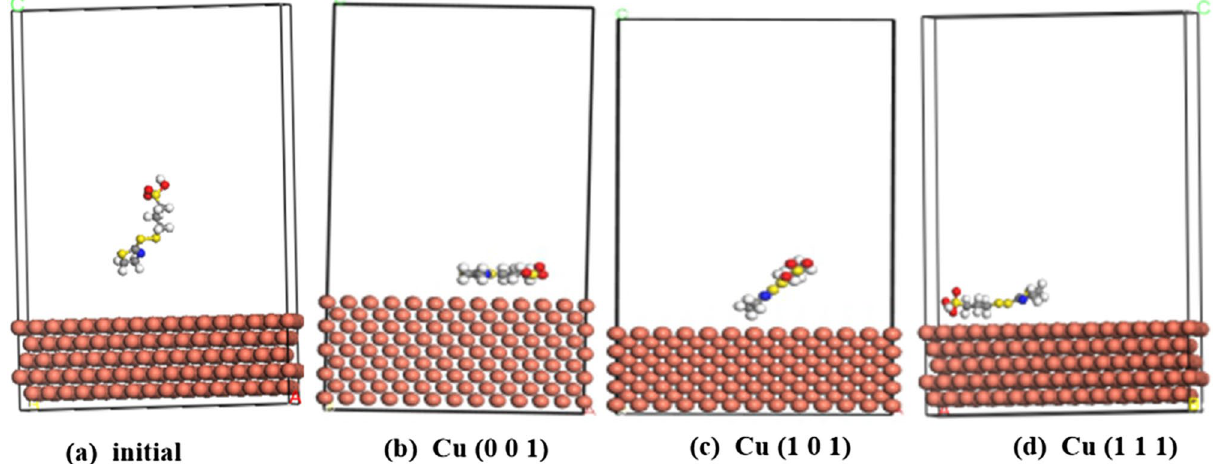
Figure 5. Configuration of SH110 adsorbed on Cu (001), Cu (101) and Cu (111) surface. ( a ) Side view of initial stage on Cu (111), ( b ) side view of equilibrium stage on Cu (001) surface ( c ) side view of equilibrium stage on Cu (101) surface. ( d ) side view of equilibrium stage on Cu (101) surface (